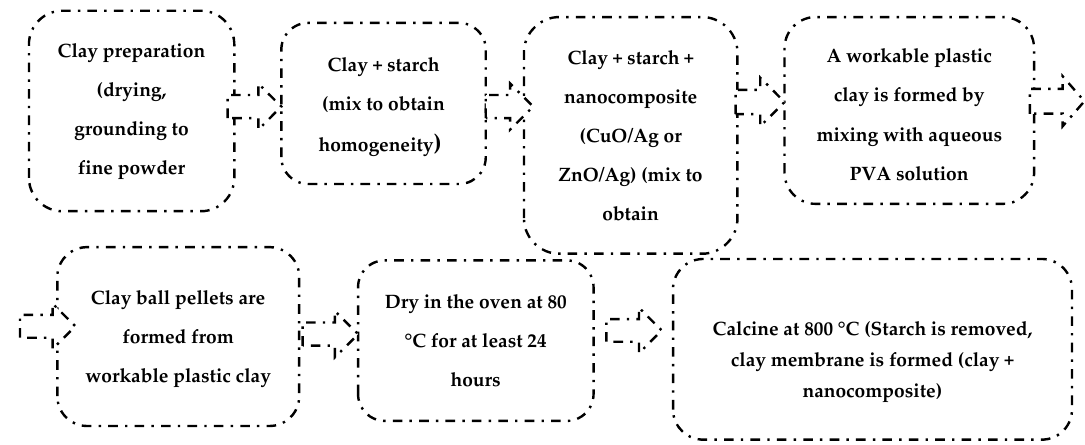
Figure 1. Annotated diagram for the synthesis of clay-nanocomposites.